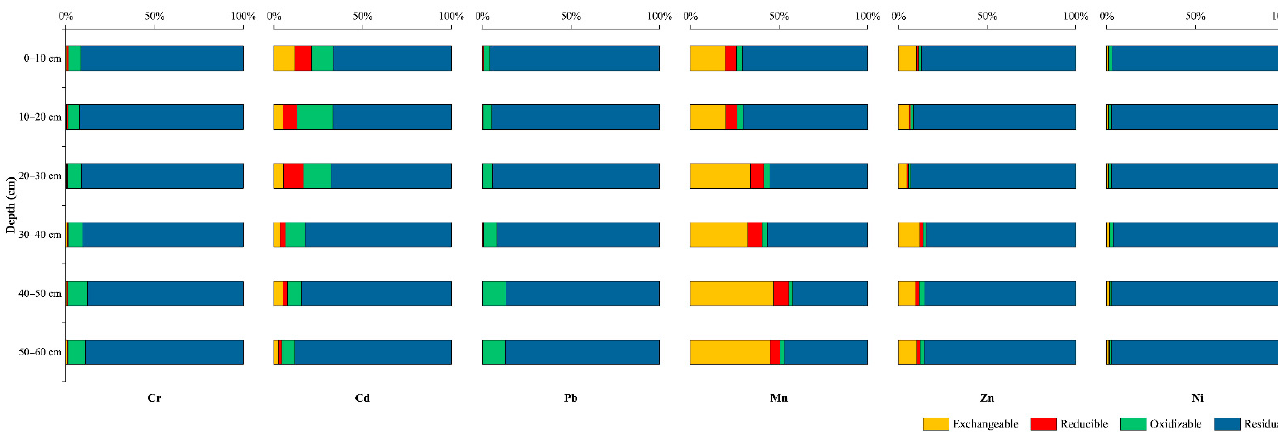
Figure 5. Percentage of each speciation for heavy metal in profile samples in HJR.